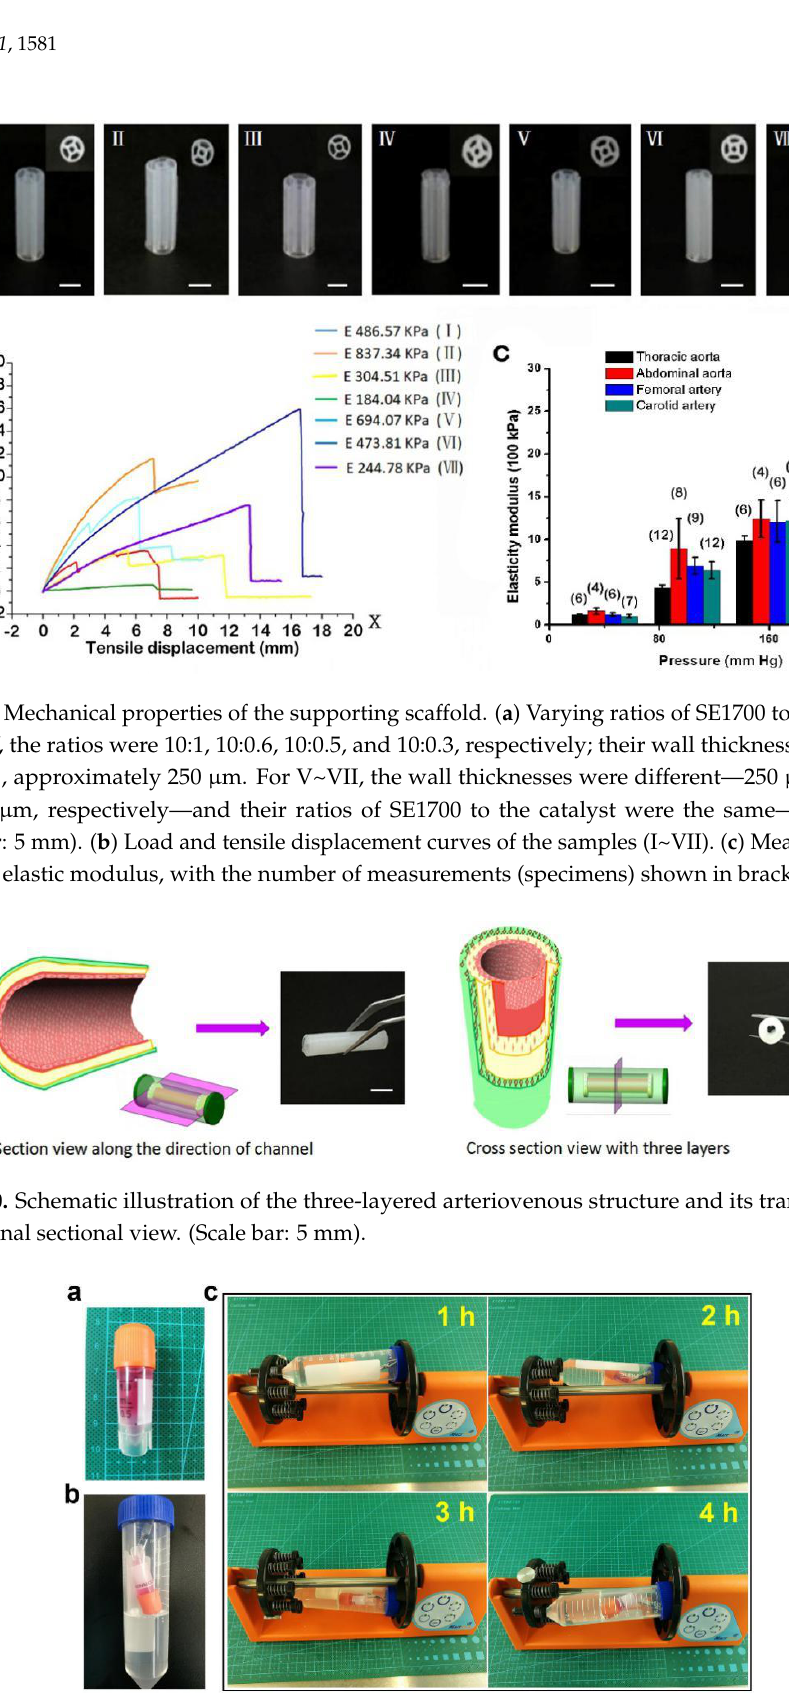
Figure 11. The rotating stage. ( a ) An arteriovenous structure in a 1-mL frozen storage tube, filled with cells and medium. ( b ) The frozen storage tube was put into the centrifuge tube and then settled. ( c ) The rotating process.